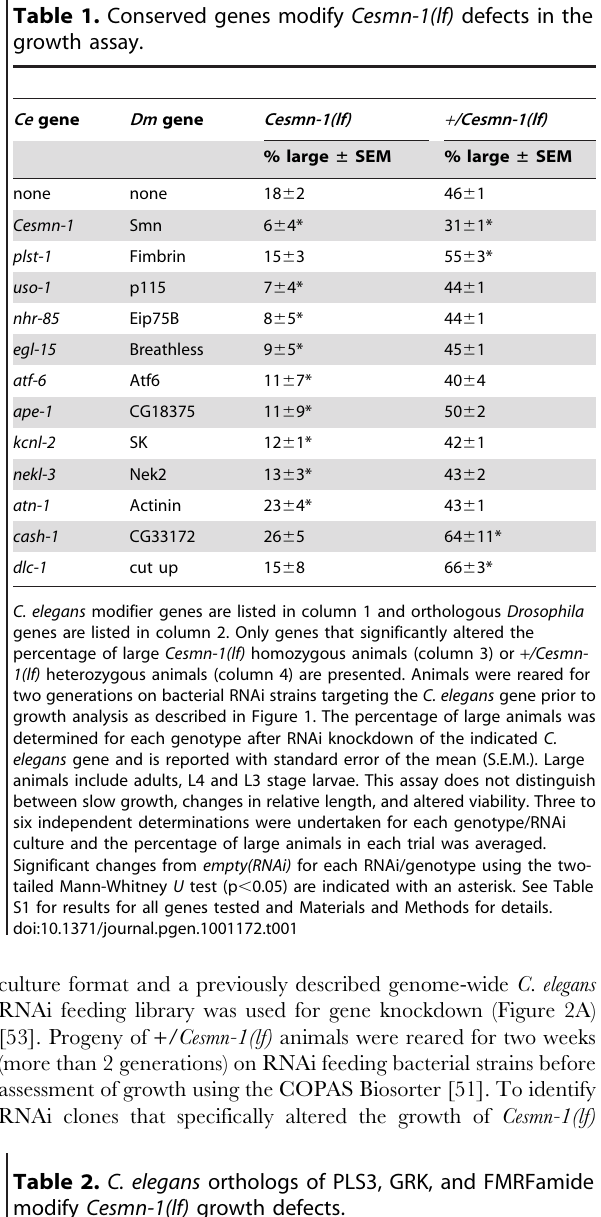
Table 1. Conserved genes modify Cesmn-1(lf) defects in the growth assay.